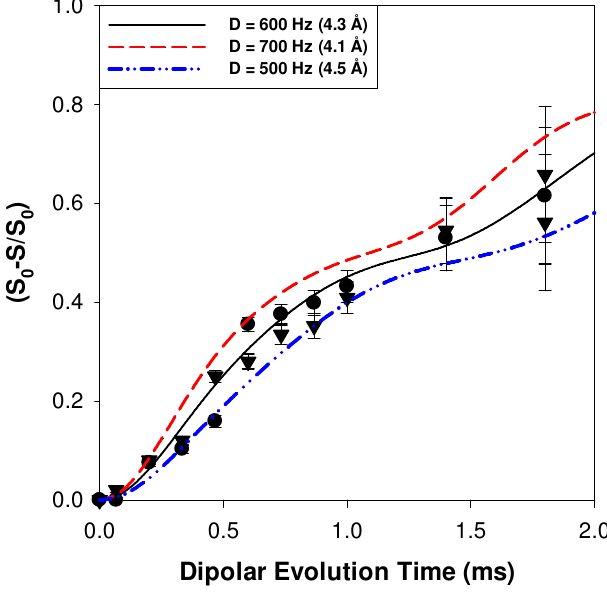
Figure 5. 1 H- 7 Li REDOR MAS NMR buildup curves for the average carboxylic